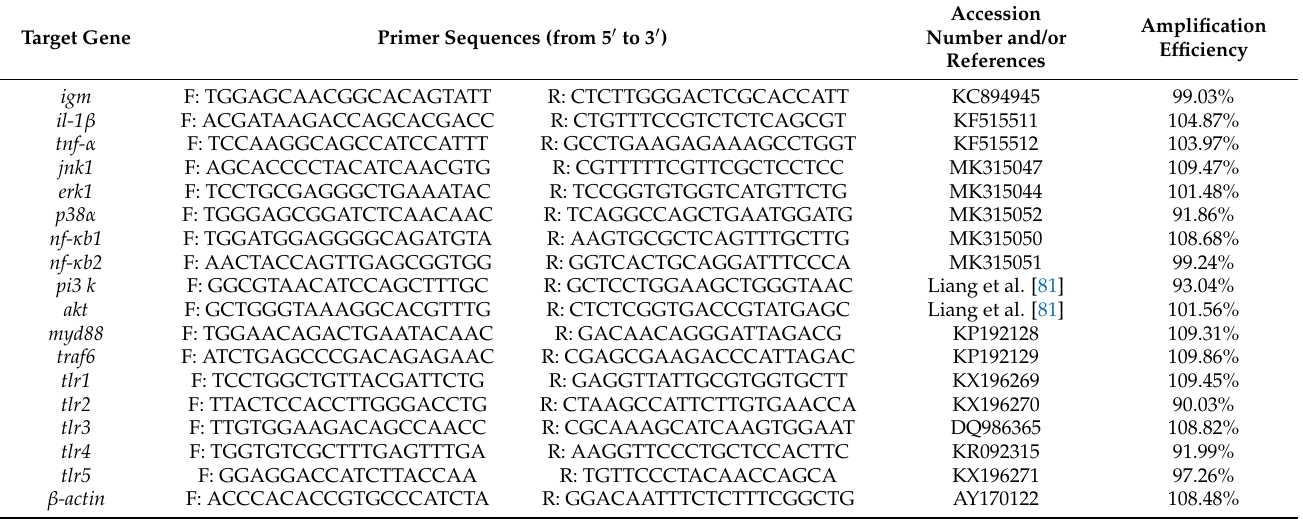
Table 3. Sequences of primers used for Qpcr